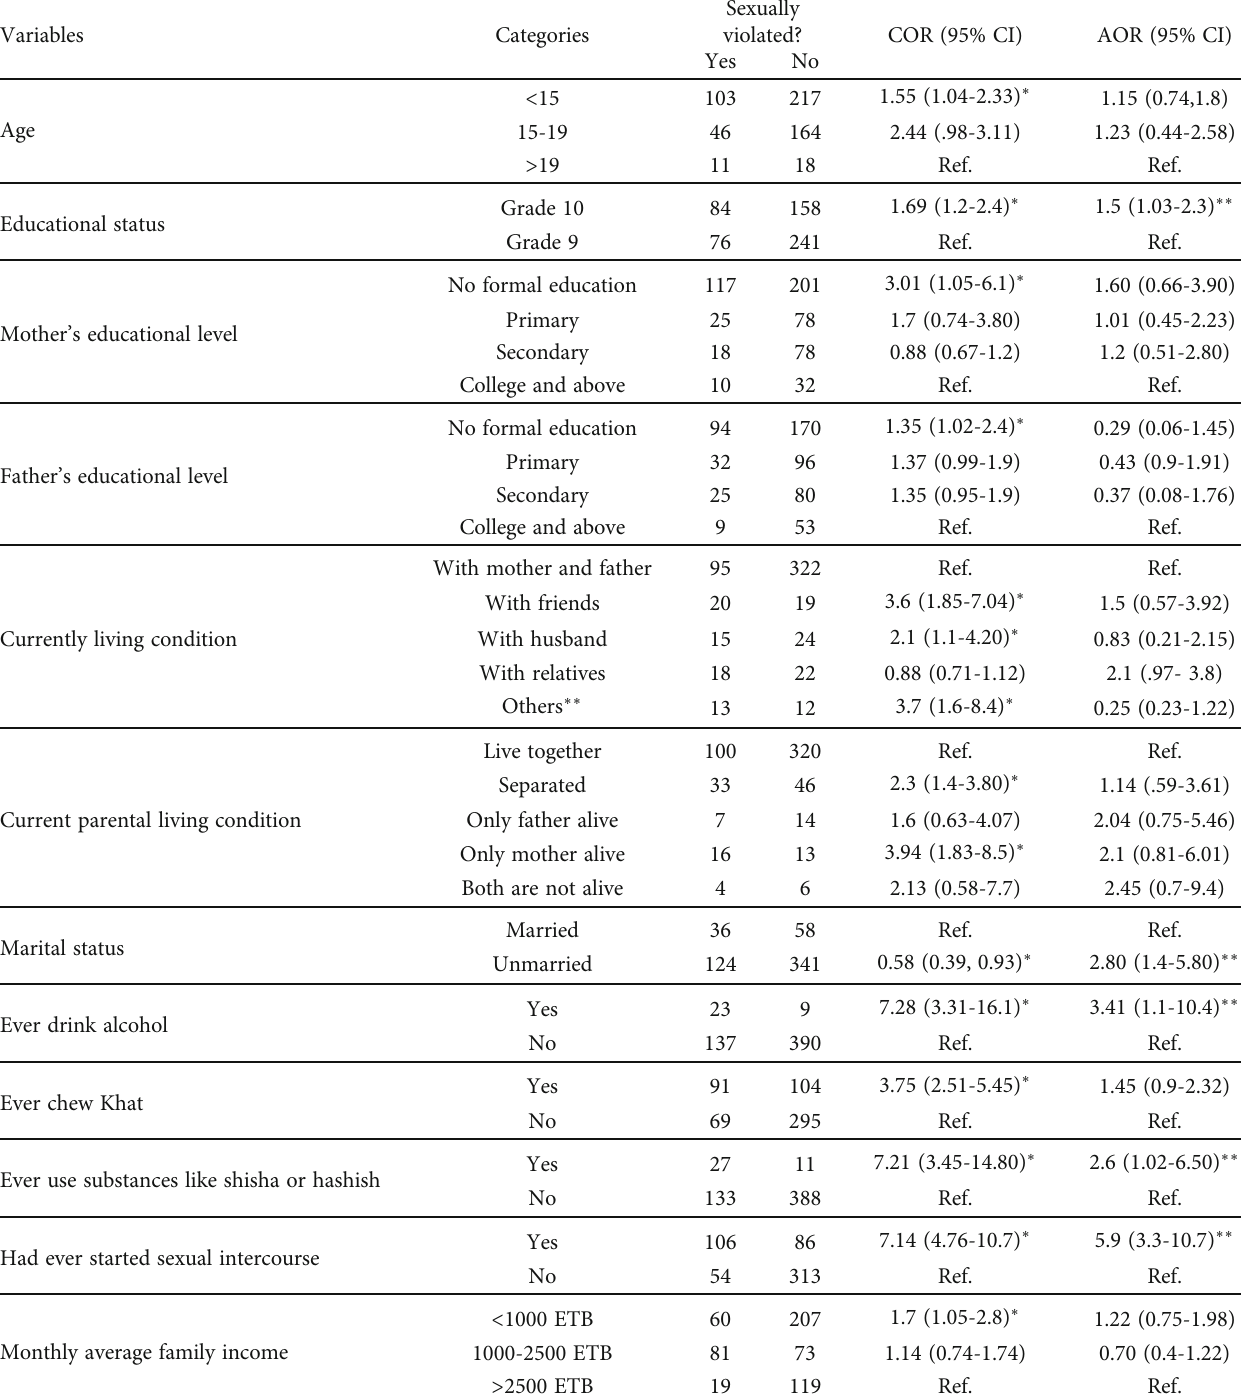
Table 4: Factors associated with sexual violence among high school female students in Jarso district, Oromia region, eastern Ethiopia, 2019 ( n = 559